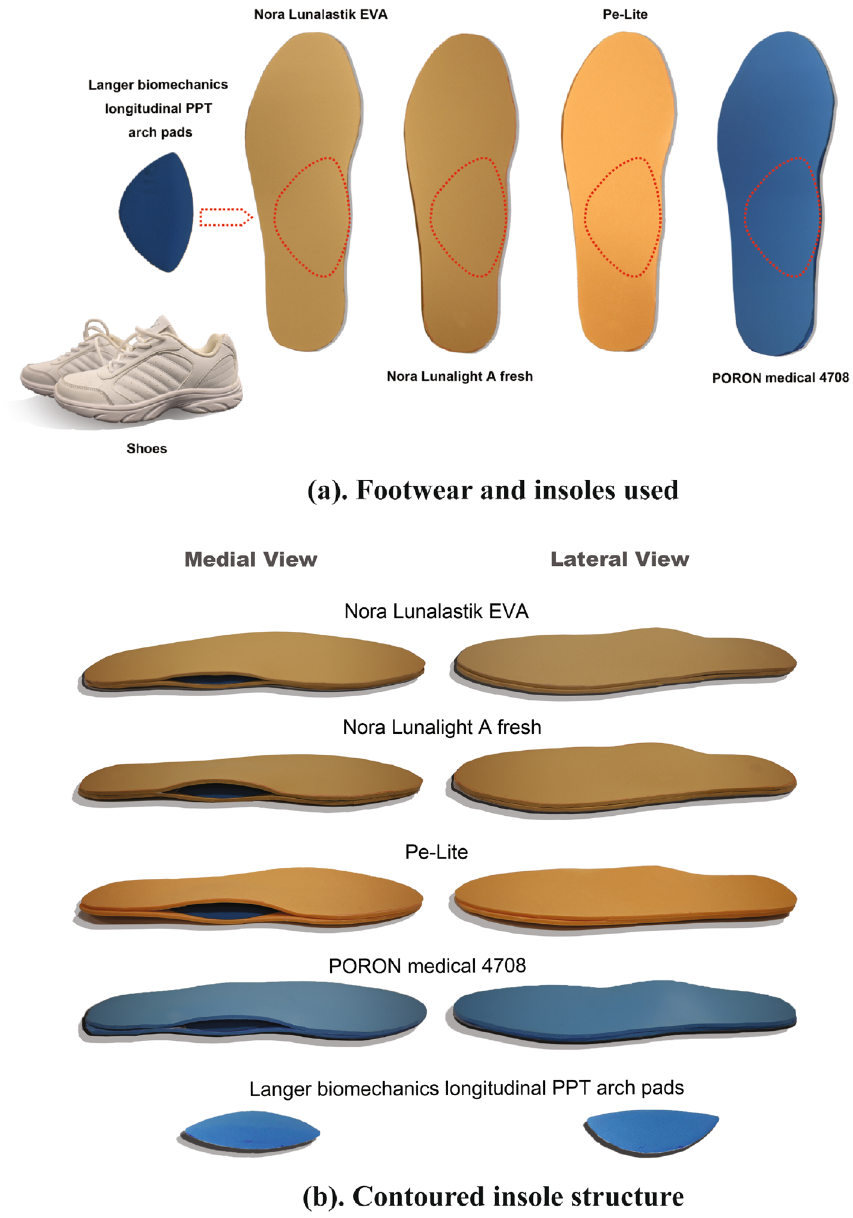
Figure 1. ( a ) Footwear and insoles used. ( b ) Contoured insole structure.